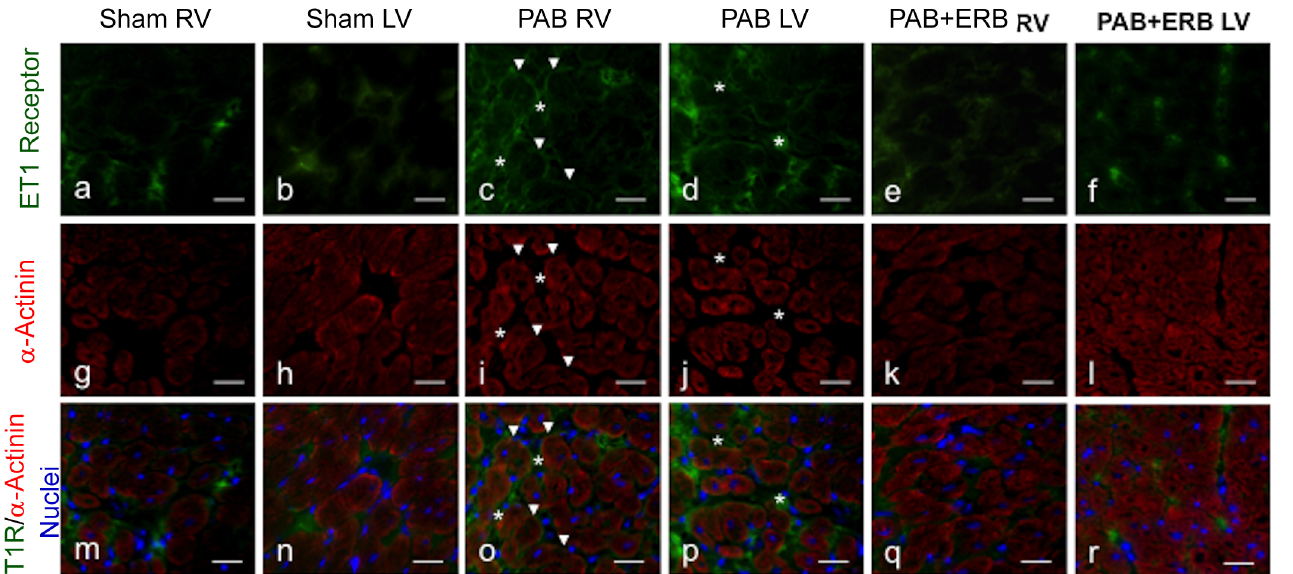
Fig 6. Immunofluoresence staining showing the immunolabeling of ET-1 Receptor of myocytes. Using myocardial samples from sham, PAB, and PAB + ERB treatment from both the RV and LV. Images a-f represents ET-1 receptor (in green), images g-l (in red) represents α -actinin (myocyte marker). Merged images shown in m-r , nucleis are colored blue. The staining shows the expression pattern of ET receptor on cardiomyocytes membrane (arrow), and interstitial area ( * ). Original magnification, ×400. In sham myocardium, the ET-1 receptor was positively labeled in the membrane of cardiac myocytes and interstitial cells ( a, b ). After PAB, ET-1 receptor strongly labeled myocytes membrane as well as interstitial cells ( c, d ) and decreased after ERB treatment ( e, f ) in both RV and